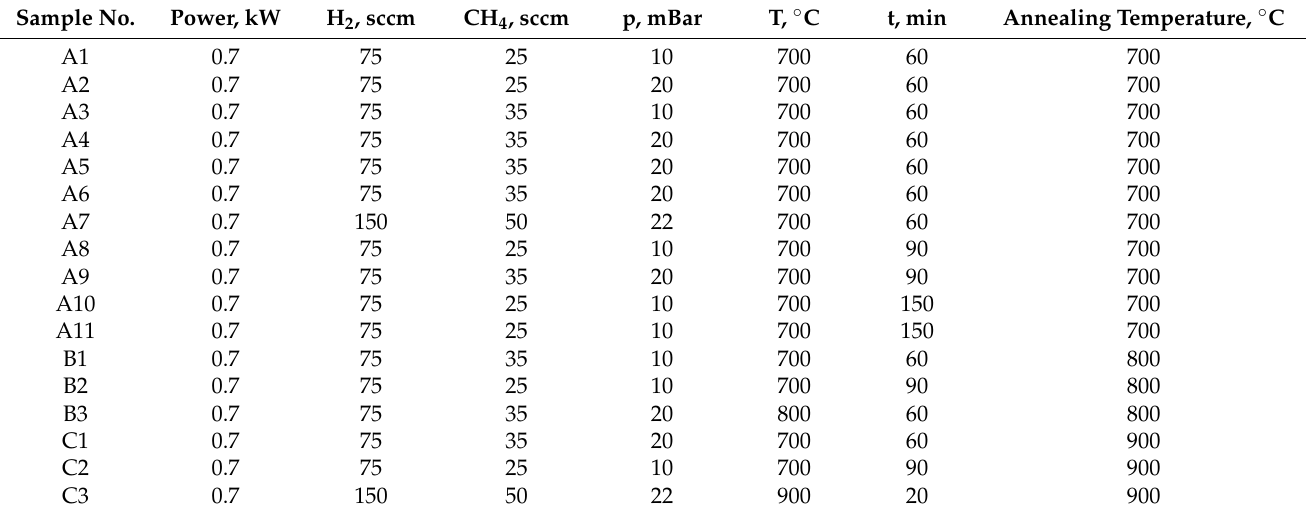
Table 1. Synthesis conditions for investigated graphene samples.